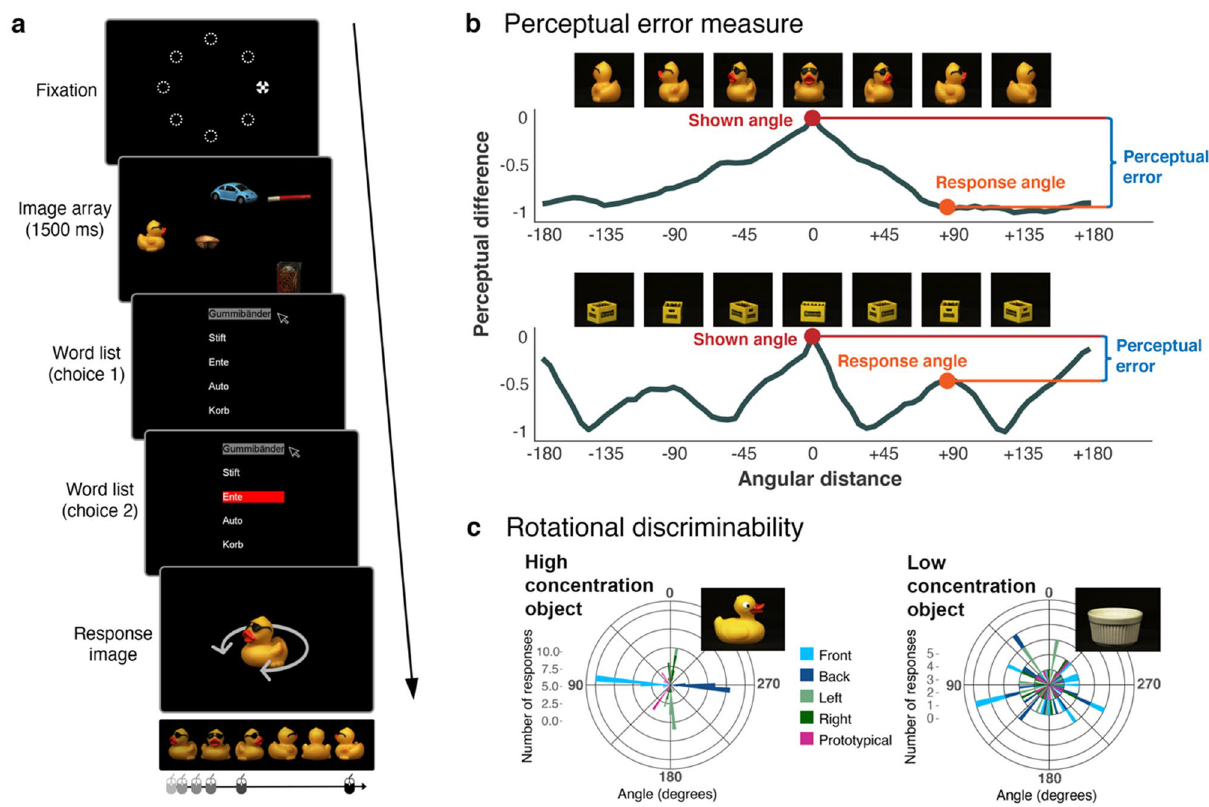
Figure 2. Methods. ( a ) Overview of experimental procedure: after fixation, an array of five objects at random rotations appeared for 1500 ms. Participants were free to inspect this array throughout this period. They were then asked to choose two objects they would prefer to report, and then rotate an on-screen image of one of the objects to match the shown rotation. The report object was more likely to be a chosen object, but non-chosen objects might also be probed. ( b ) Example of the perceptual error measure for two objects, based on low- level image properties: the top graph shows an object where angular difference corresponds almost linearly to perceptual dissimilarity. The bottom graph shows a regularly-shaped object where perceptual similarity peaks every 90° rotation. Perceptual error was calculated as the difference in perceptual similarity 28 between shown and response angles: the same angular distance can result in a different perceptual distance for different objects. ( c ) Rotational discriminability (empirical) was measured in a separate, online study, and was estimated as the concentration of responses to axis labels for each object. Examples show a low and high concentration object, equating to low and high